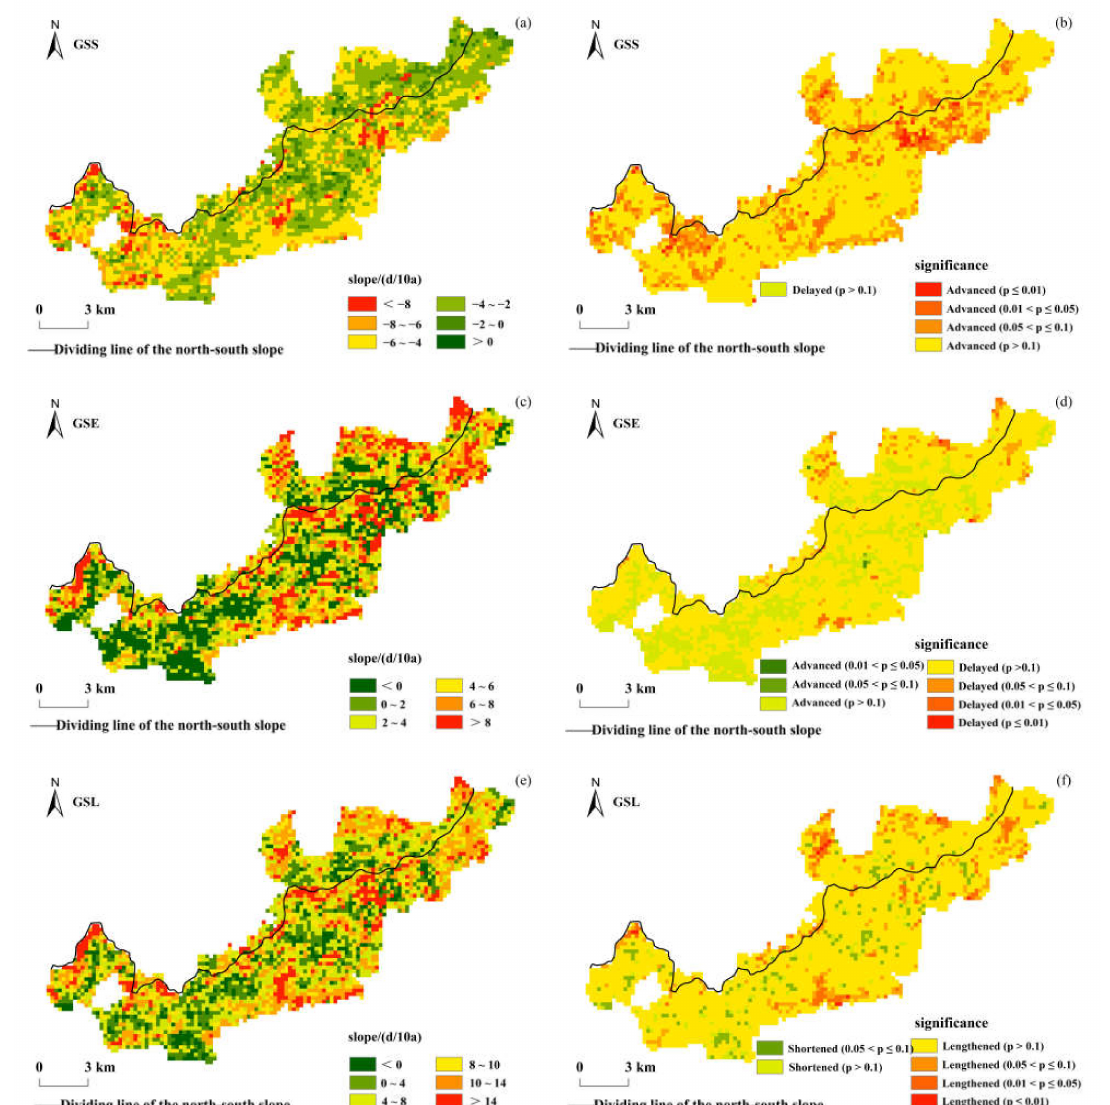
Figure 4. Spatial distribution of interannual change trends of the vegetation phenological parameters in Niubeiliang Reserve from 2000 to 2017 and their significances. ( a ) Slope of the GSS; ( b ) significance of the GSS; ( c ) slope of the GSE; ( d ) significance of the GSE; ( e ) slope of the GSL; ( f ) significance of the